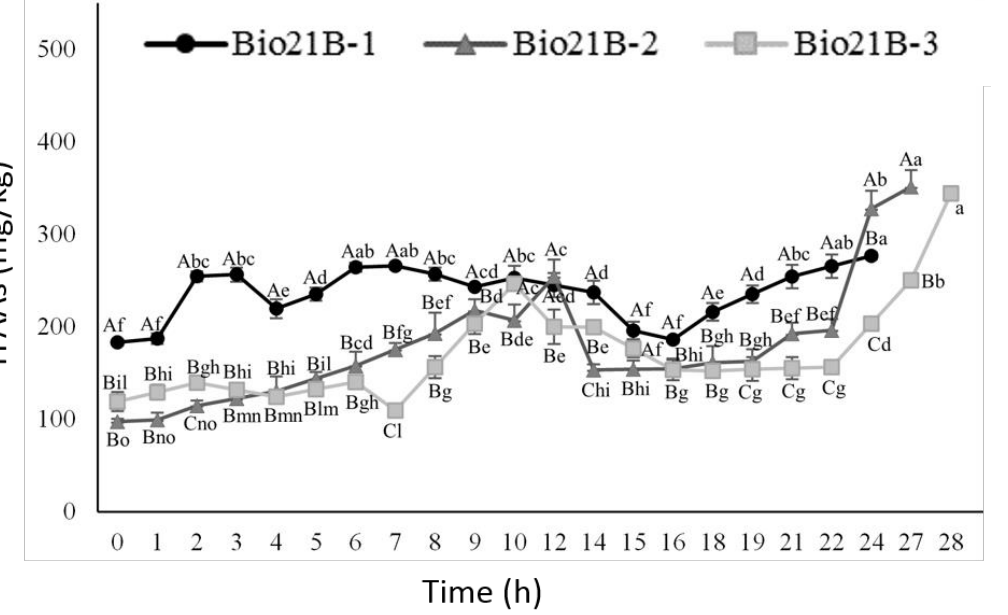
Figure 5. Content of TFAA—total free amino acid content (mg/kg) in liquid sourdoughs Bio21B-1, Bio21B-2, and Bio21B-3 prepared as reported in Section 2.3 and Table 1, during L. plantarum ITM21B fermentation. Data are the means of three replicates and bars indicate standard deviation. Different capital letters (A–C) indicate significant differences ( p < 0.05) among different samples within the same incubation time. Different lowercase letters (a–o) indicate significant differences ( p < 0.05) among incubation times within the same sample.